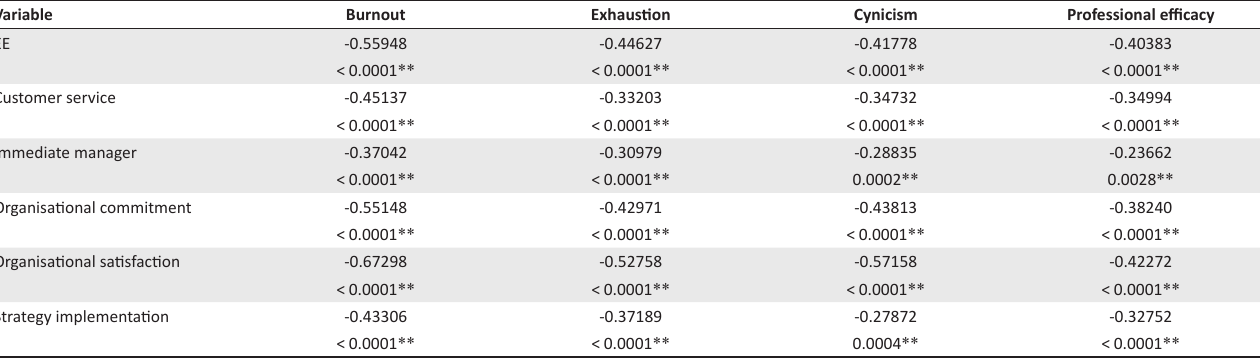
TABLE 1: Correlations between subscales of employee engagement and burnout: Pearson product-moment correlation coefficients, N = 158. Variable